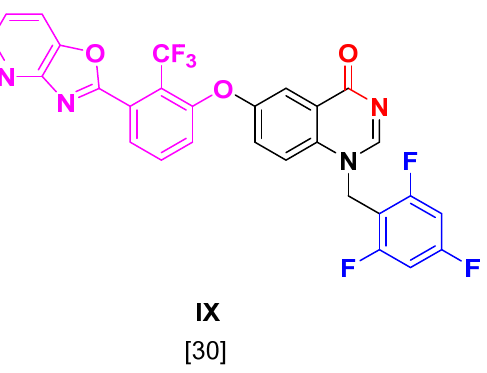
Figure 6. Structure of co-crystallized ligand of 4JU1 used for redocking. Table 3. Docking data.